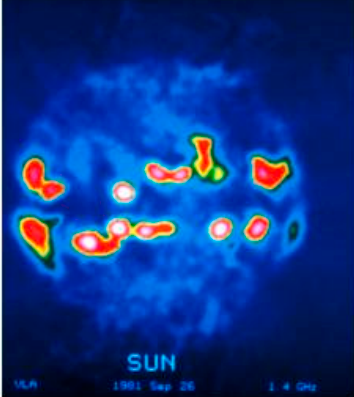
Figure 12. L-band BT emission of the Sun [16].